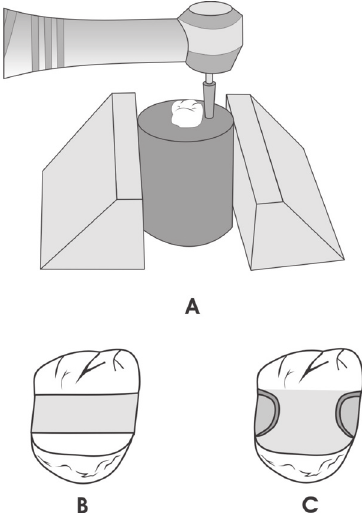
Figure 2- Sequence of tooth cavity preparation using a high-speed handpiece perpendicularly adjusted to the oclusal surface of teeth. A: Tooth positioned into a machine in order to standardize the cavity dimensions of each tooth until cusp grinding step. B: Occlusal box was made beginning with grinding in a slot shape. C: The proximal boxes were made in the machine followed by additional manual grinding of the largest